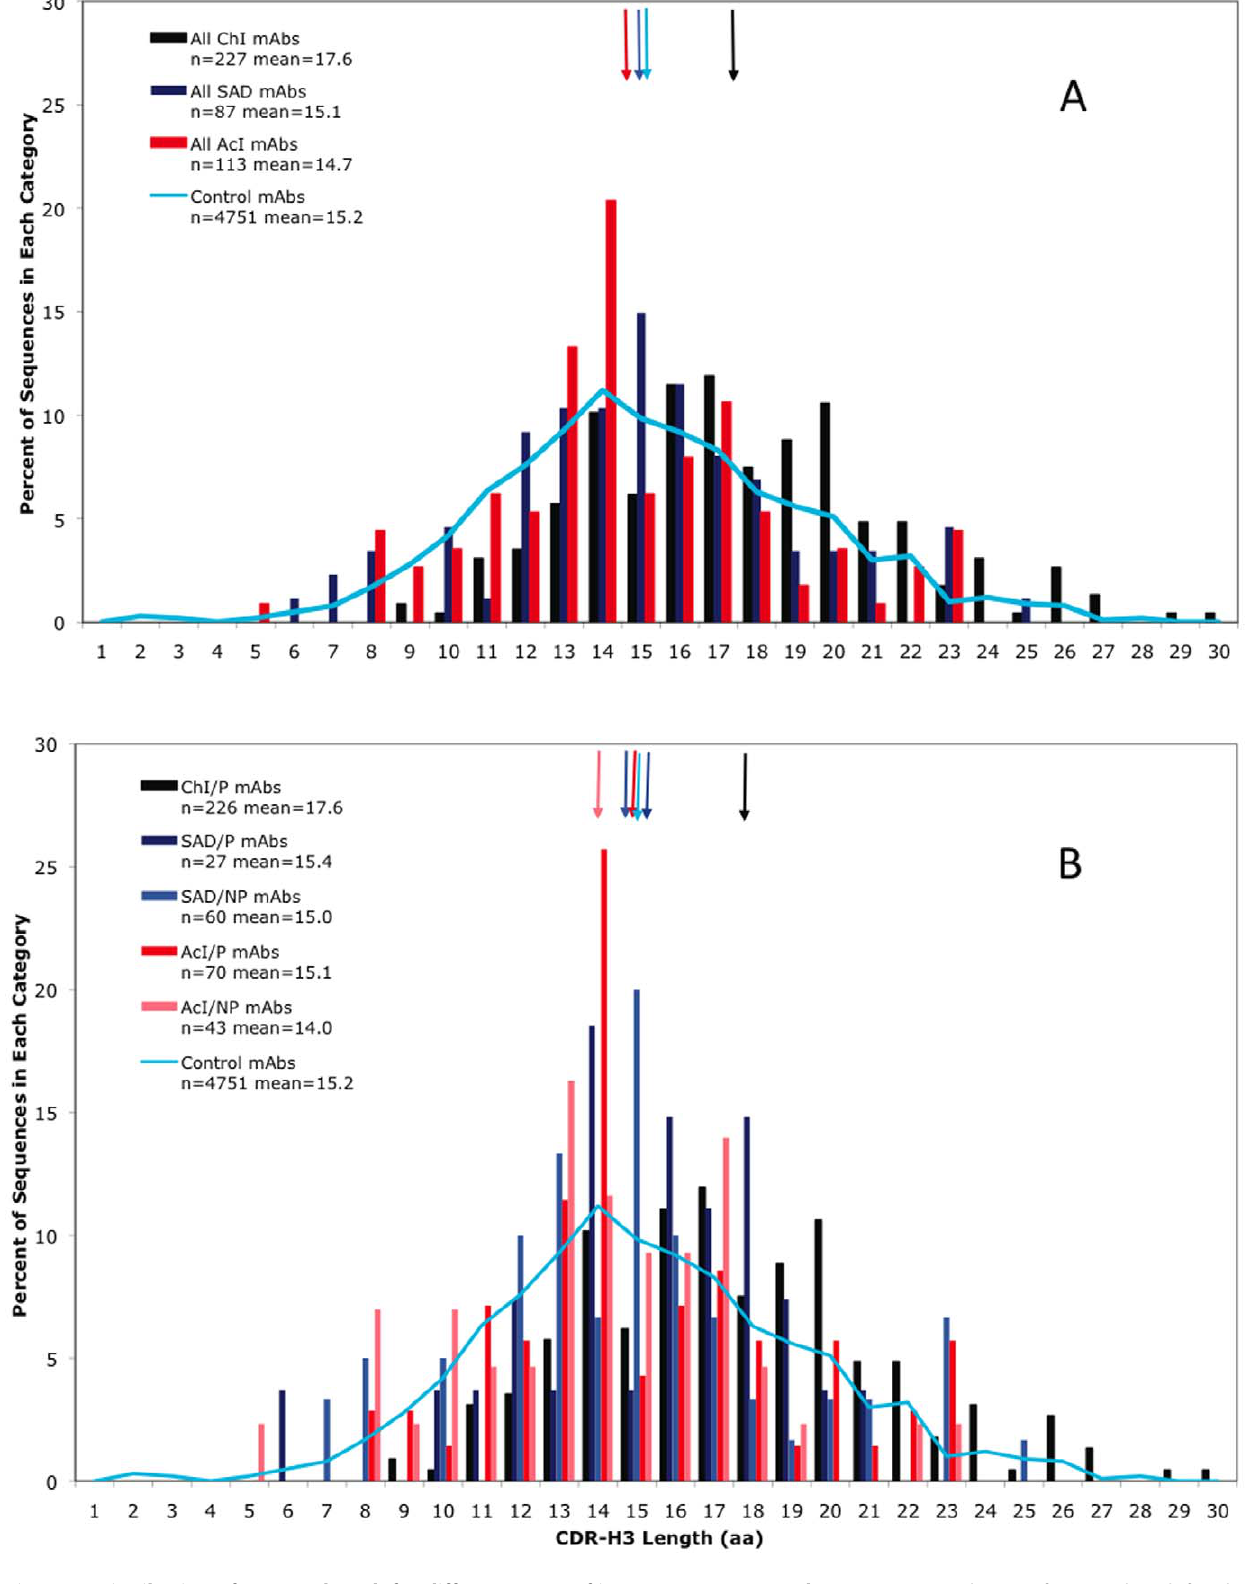
Figure 3. Distribution of CDR-H3 length for different types of immune response and Ag type. A. Distribution of CDR-H3 length for ChI, SAD, and AcI MAbs. B. Distribution of CDR-H3 length for ChI anti-protein, SAD anti-protein, AcI anti-protein, SAD anti-non-protein, and AcI anti-non- protein MAbs. Arrows indicate the means for each category. Control MAbs (blue line) are included for comparison [63].